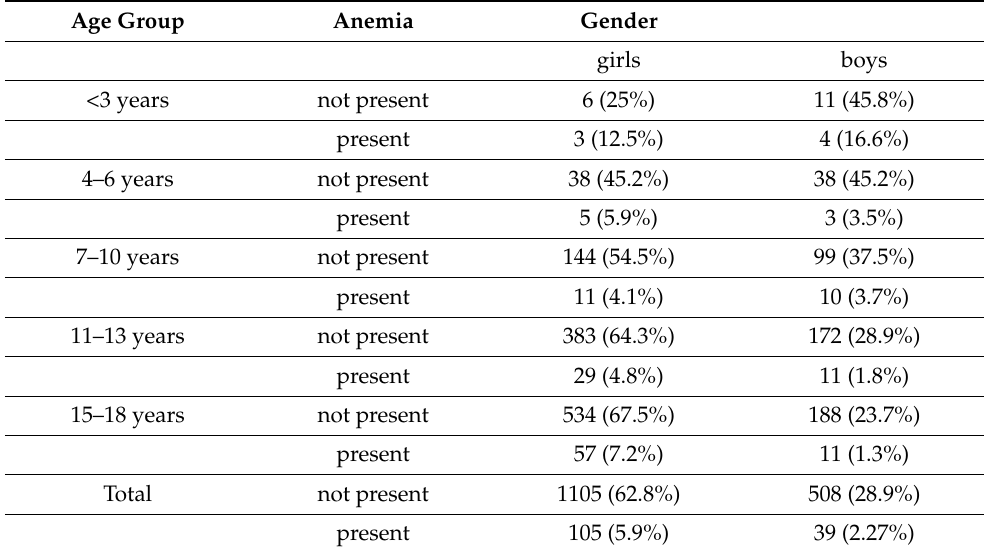
Table 3. Anemia and gender within various age